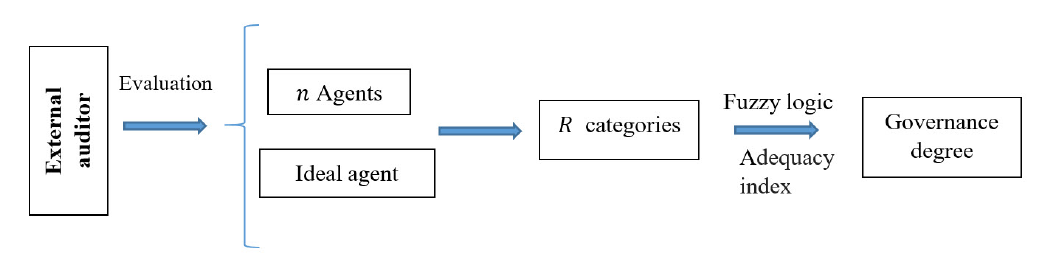
Figure 5. Governance structure.